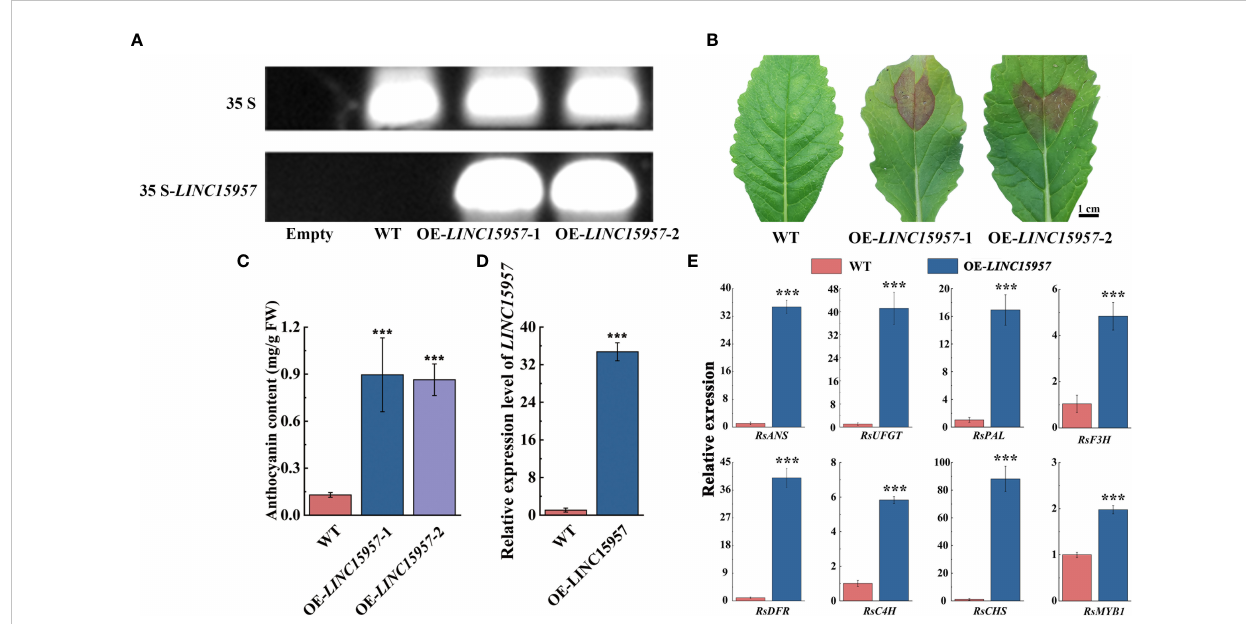
FIGURE 2 The transiently expressed LINC15957 in radish leaves. (A) The PCR validation of LINC15957 in OE- LINC15957 and control. The upper band indicates 35S and the lower band indicates LINC15957 is successfully transiently expressed in radish leaves. “ Empty ” is leaves without injection infection, “ WT ” is empty vector. (B) LINC15957 is transiently expressed in radish leaves. (C) Anthocyanin content in the tissue of injection empty, OE- LINC15957 -1 and OE- LINC15957 -2. (D) The gene expression level in OE- LINC15957 . (E) Expression pattern of key anthocyanin biosynthetic genes in OE- LINC15957 . RsACTIN was used as reference gene for normalization. Error bars represent the mean ± SE of three biological replicates. ***p < 0.001, Student ’ s